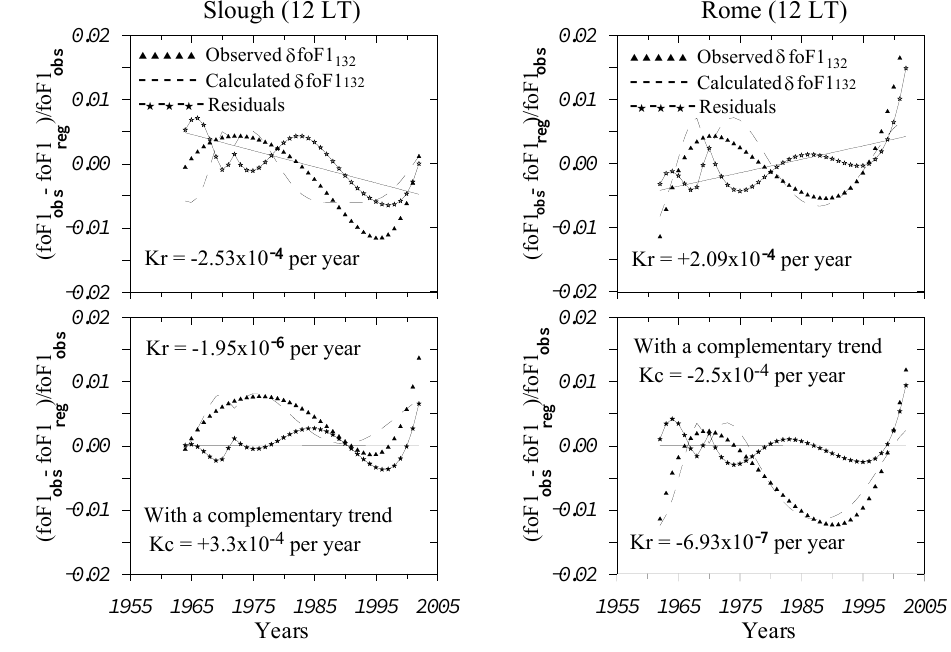
Figure 3 Fig. 3. Observed, calculated δ fo F1 132 and their difference resulting in a residual fo F1 trend with the slope K r for Slough and Rome 12:00LT. The bottom panels show the results with complementary trends K c . An addition of K c practically removes the geomagnetic activity effect resulting in very small and insignificant residual